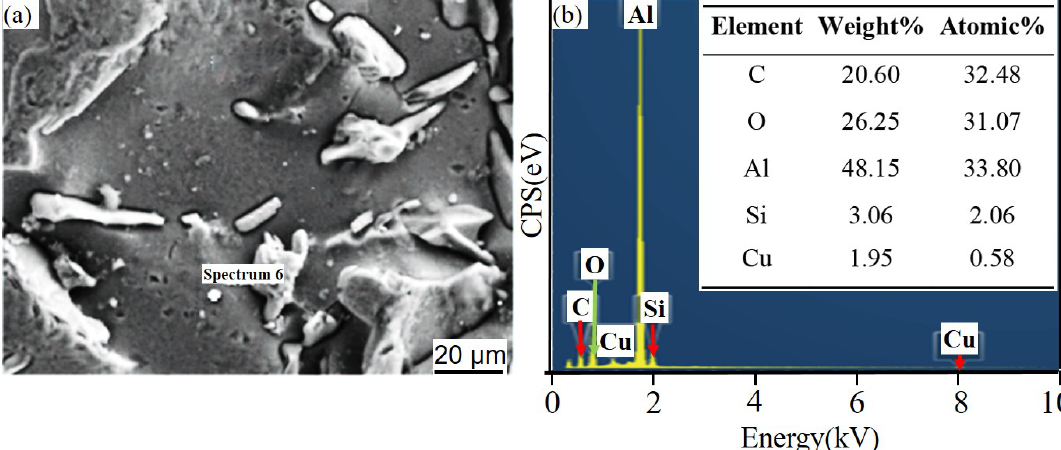
Figure 17. EDS of particles surrounding a circle of SiC 3D /6061Al after SL for 61 days. ( a ) SEM image of particles surrounding a circle; ( b ) EDS of particles surrounding a circle.